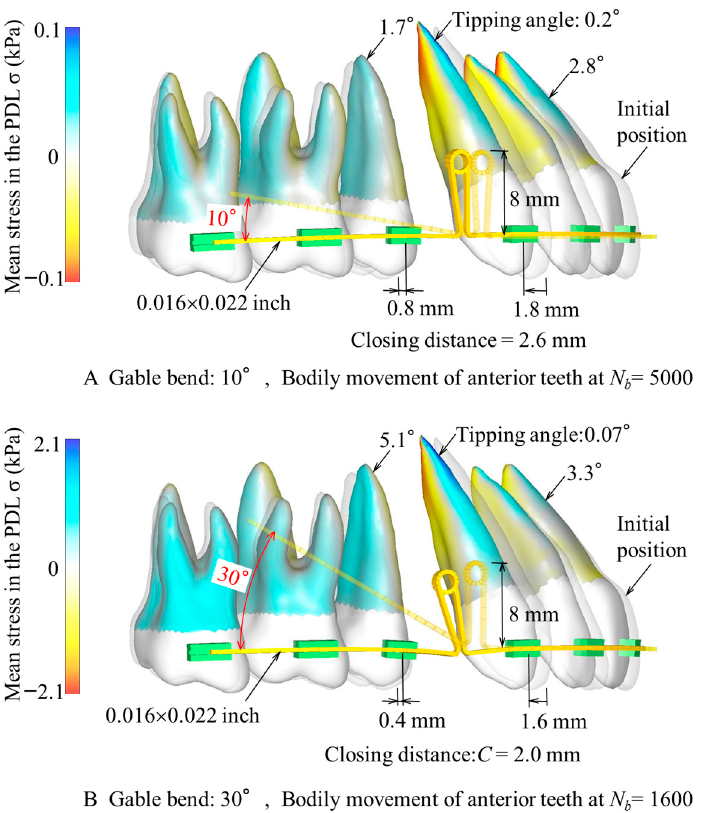
Figure 4. Effect of gable bend. When the gable bend increases, closing distance C and the number of repeated calculations N b decreases.